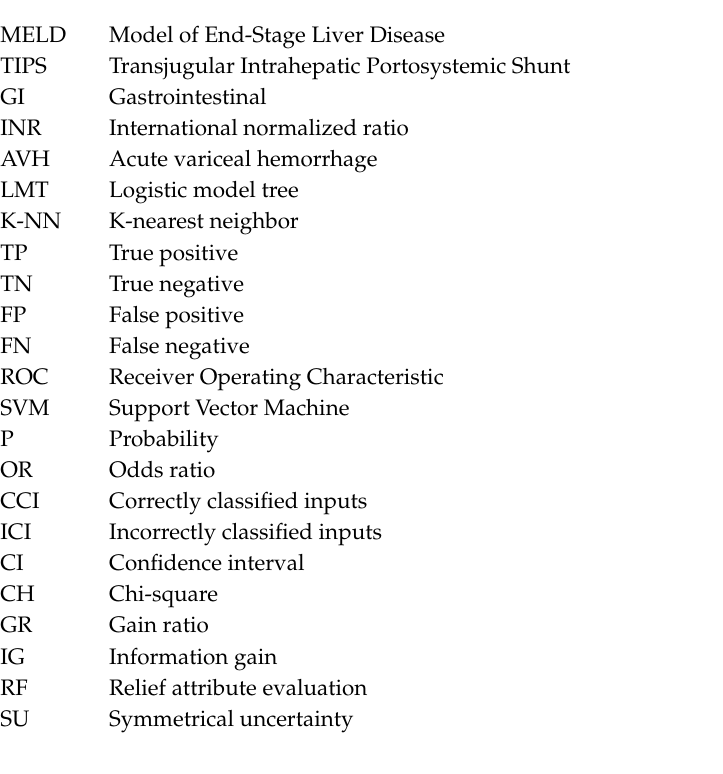
Table S1: The data in study described in (Benedeto-Stojanov, 2010) 29 attributes—involved 96 subjects by Clinical Center of Nis,